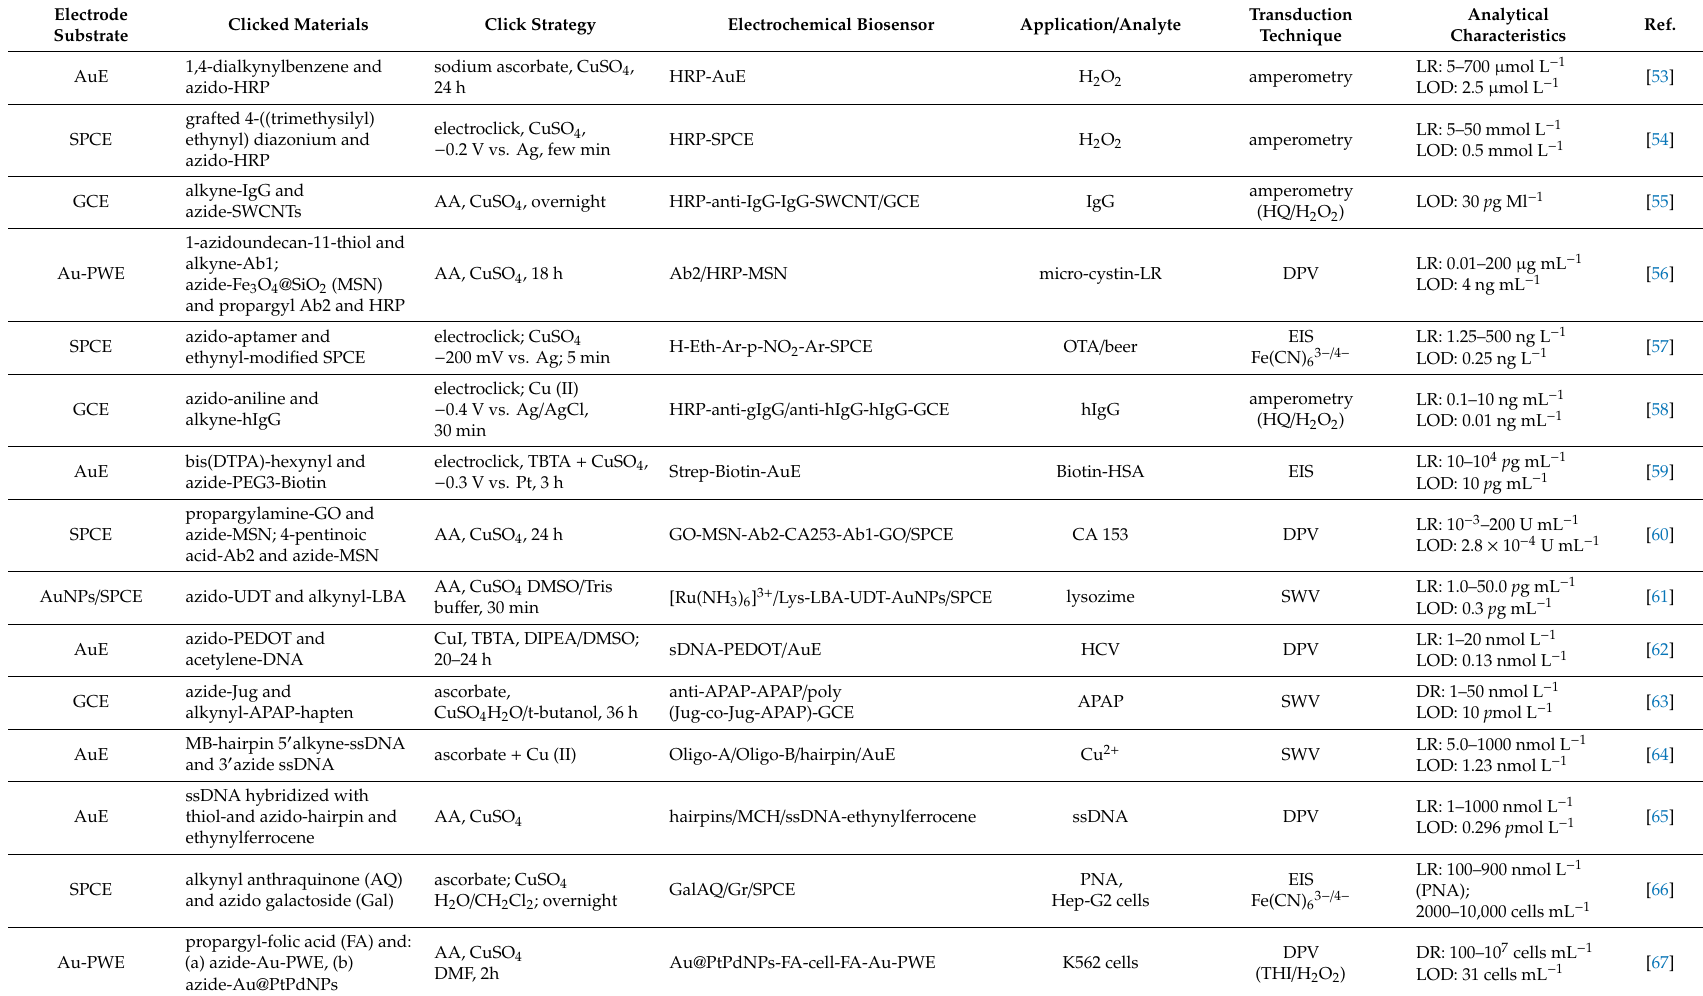
Table 2. Electrochemical biosensors prepared by Cu(I)-catalyzed azide–alkyne cycloaddition. Electrode